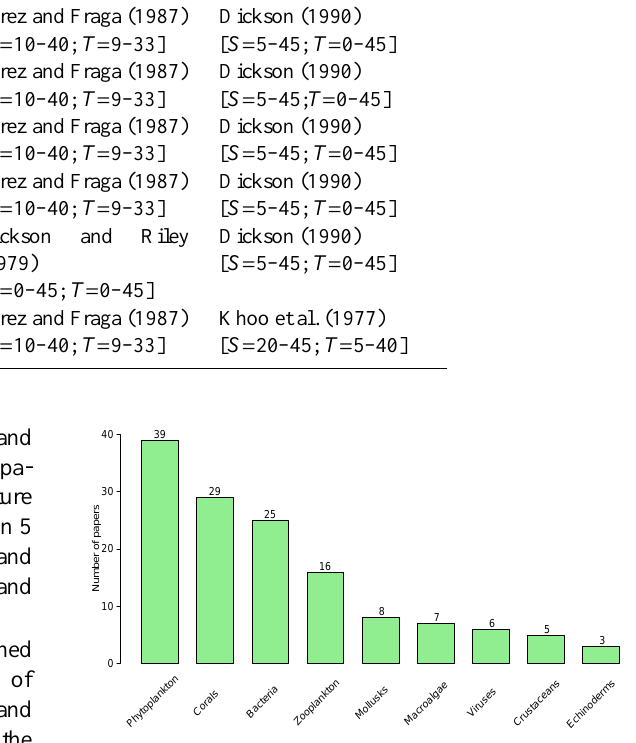
Figure 5. Taxonomic coverage of the papers included in the